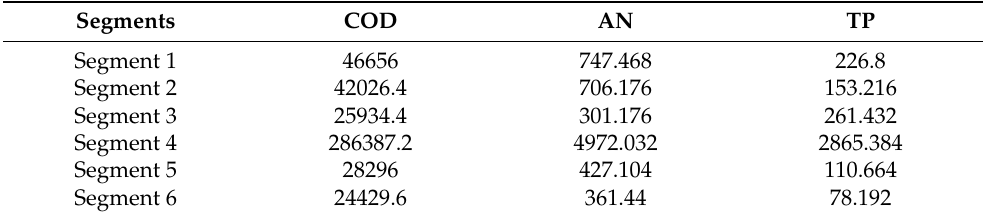
Table 3. Annual average total pollution load of COD, AN and TP in the Lushui River in 2020 (kg/d).